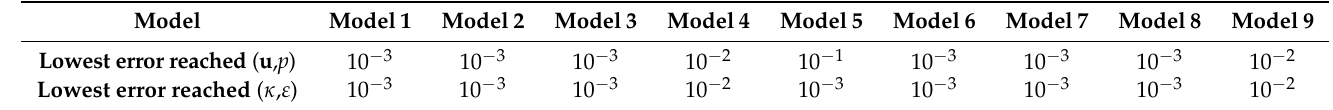
Table 5. Lowest error reached by the models.